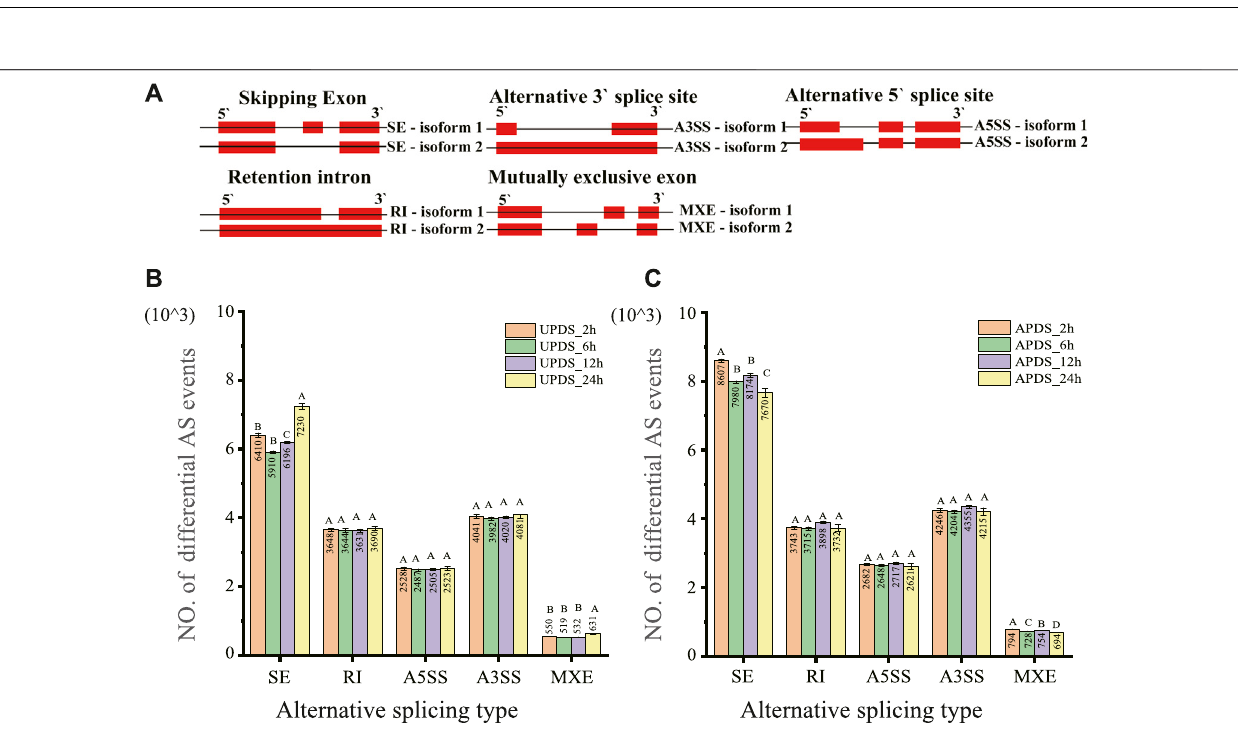
FIGURE 2 | Classes and numbers of different types of AS events detected in the transcriptome of Glycyrrhiza uralensis at different time points during drought treatment. (A) Schematic diagram of the AS: SE, A3SS, A5SS, RI, and MXE. Each event produces two types of isomers: isoforms 1 and 2. (B) Number of fi ve different types ofASevents inAPof G.uralensis atdifferenttime points underdroughtstress. (C) Number of fi ve differenttypes ofASeventsin UPof G.uralensis at differenttime points under drought stress. Data are mean ± standard deviation of three biological replicates. Mean values for different time points under drought stress were tested using the Bonferroni test. Different letters indicate highly signi fi cant differences among treatments.